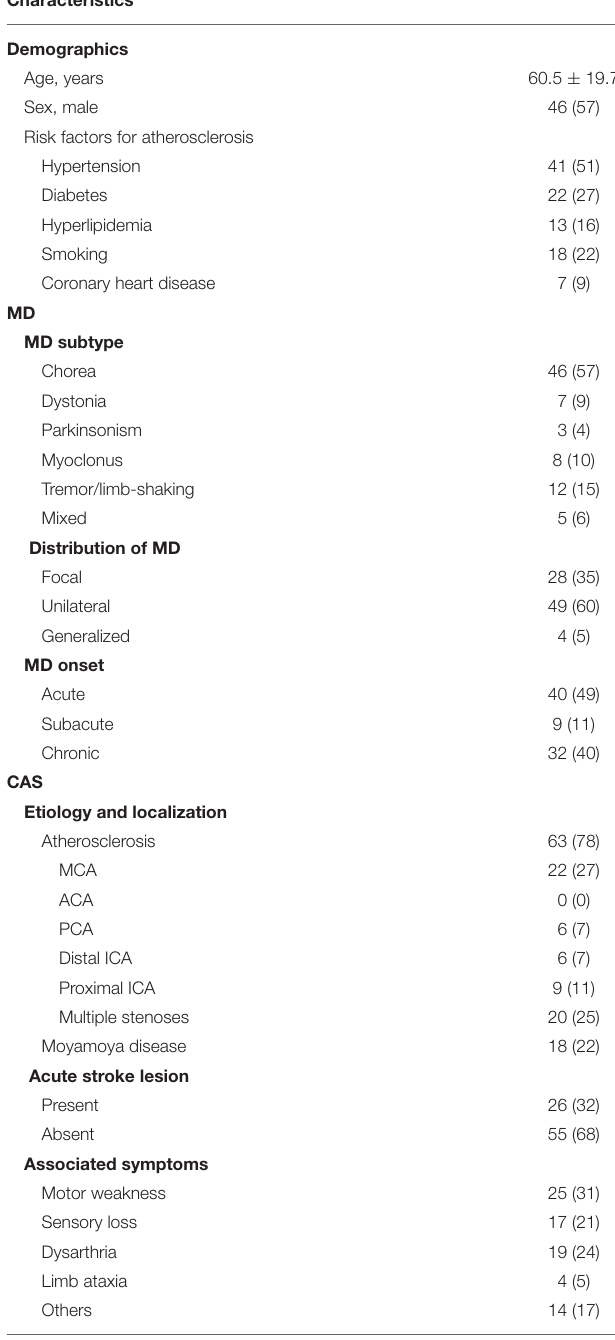
TABLE 1 | Baseline characteristics of patients ( n =